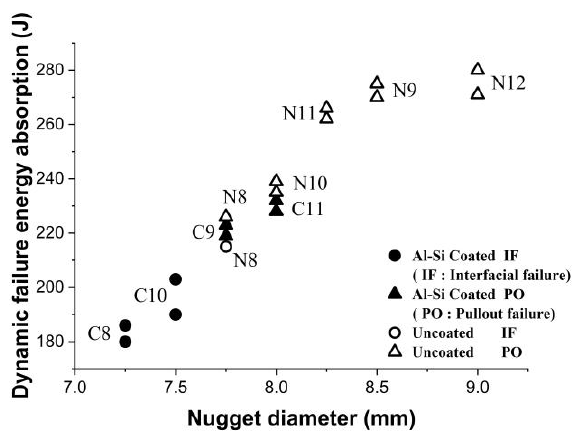
Figure 12. Dynamic failure energy absorption with nugget diameter for both types of material.